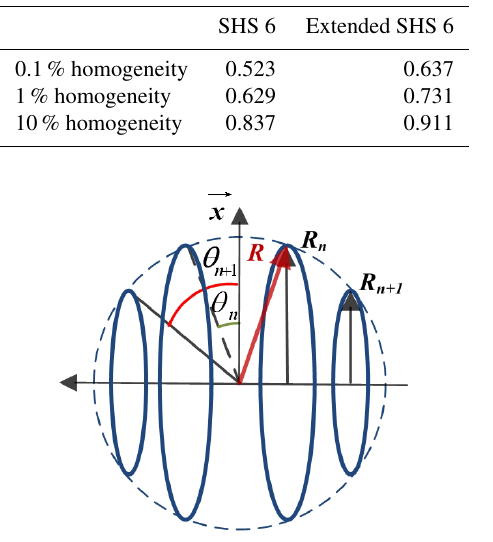
Figure 4. SHS coil constituted of N pairs of